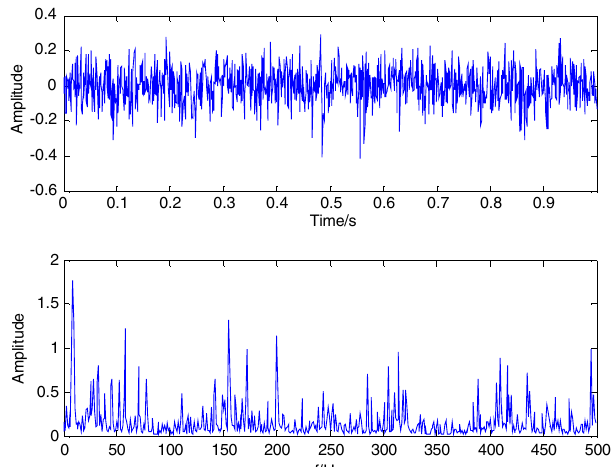
Figure 11. The time-domain distribution and spectrum of the oil pressure signal.